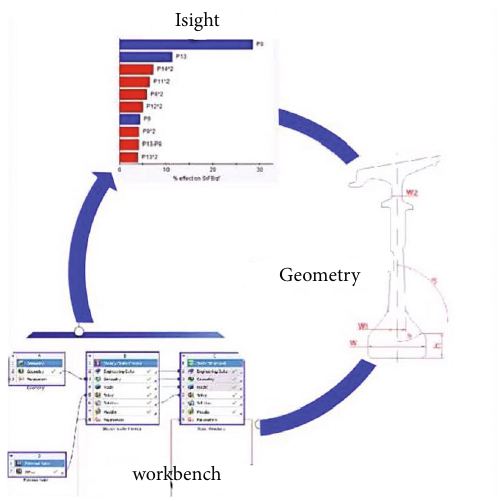
Figure 1: Design optimization